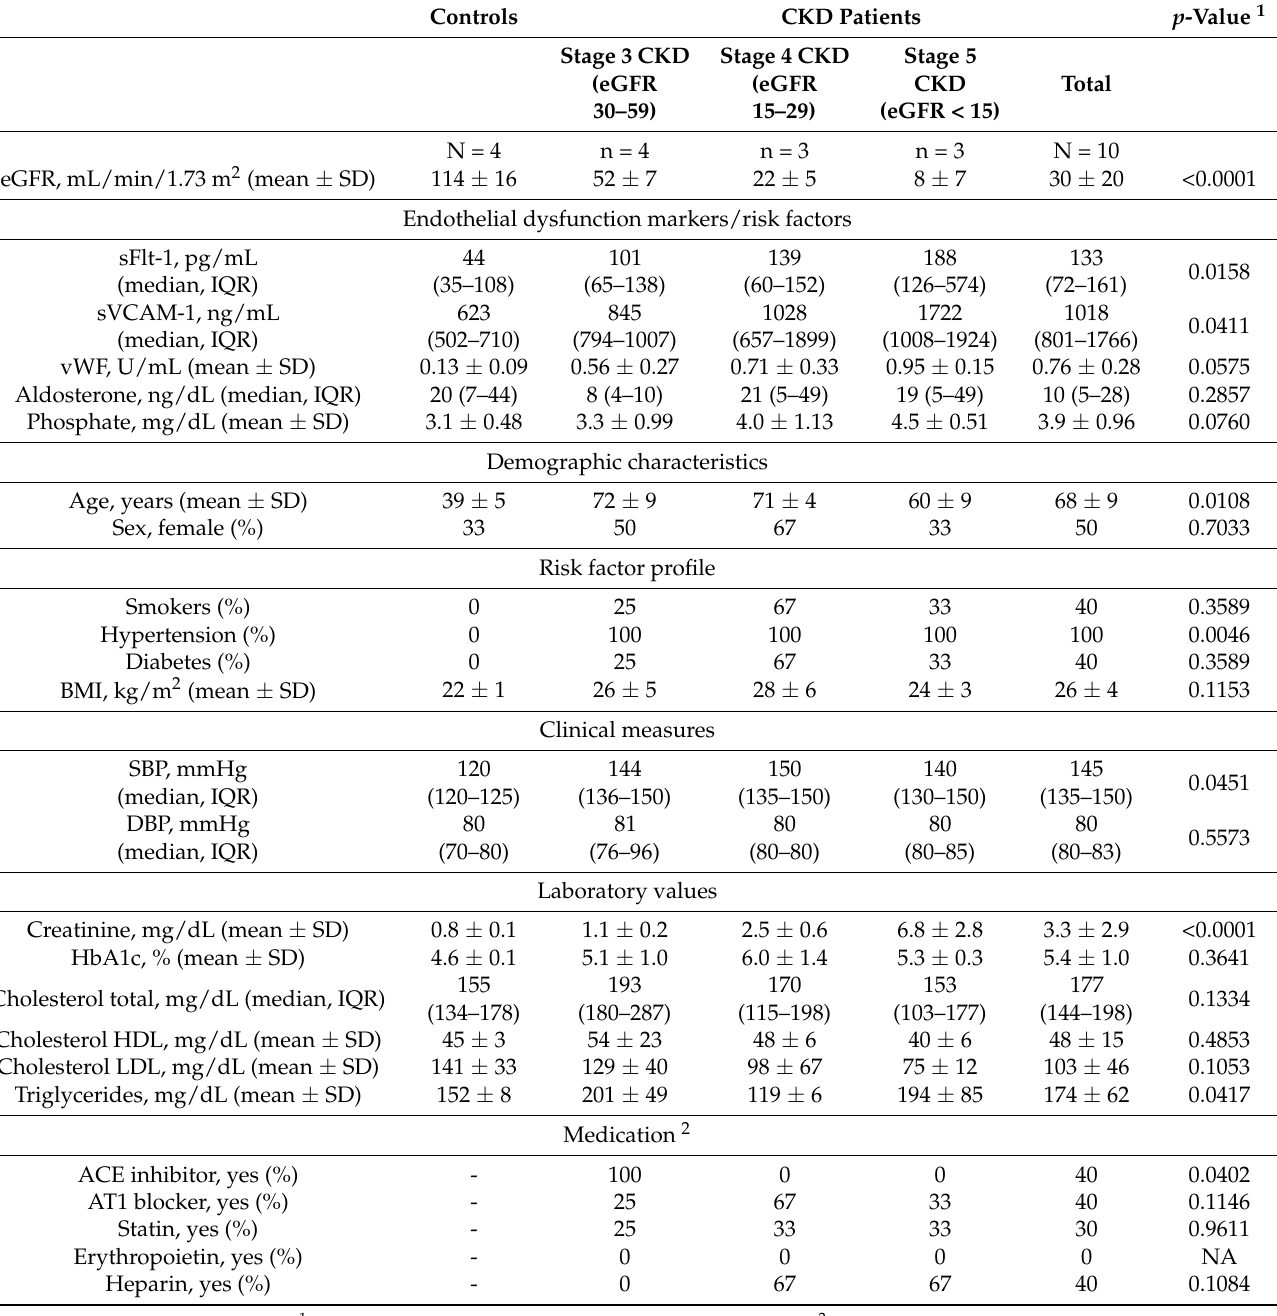
Table 1. Baseline demographics, clinical characteristics, and risk profile of the study